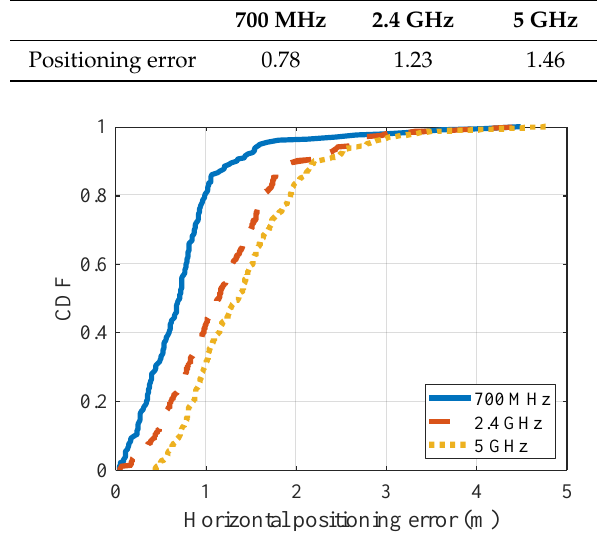
Table 5. Average of horizontal positioning error for each frequency band (m).